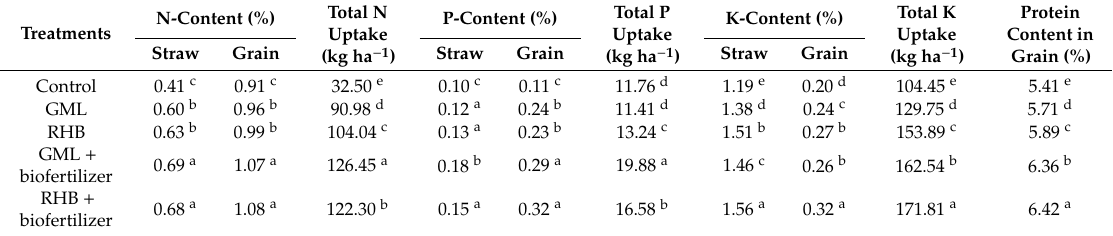
Table 8. E ff ects of applying amendments on NPK uptake and protein content in rice